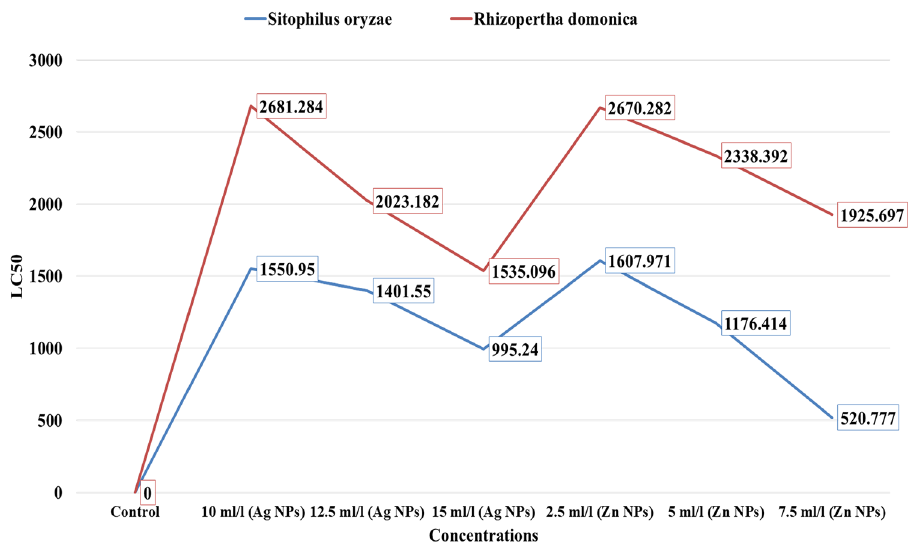
Figure 3. Insecticidal activity of acetone leaf extracts from peach trees treated with different concentrations of Zn NPs and Ag NPs against Sitophilus oryzae and Rhizopertha